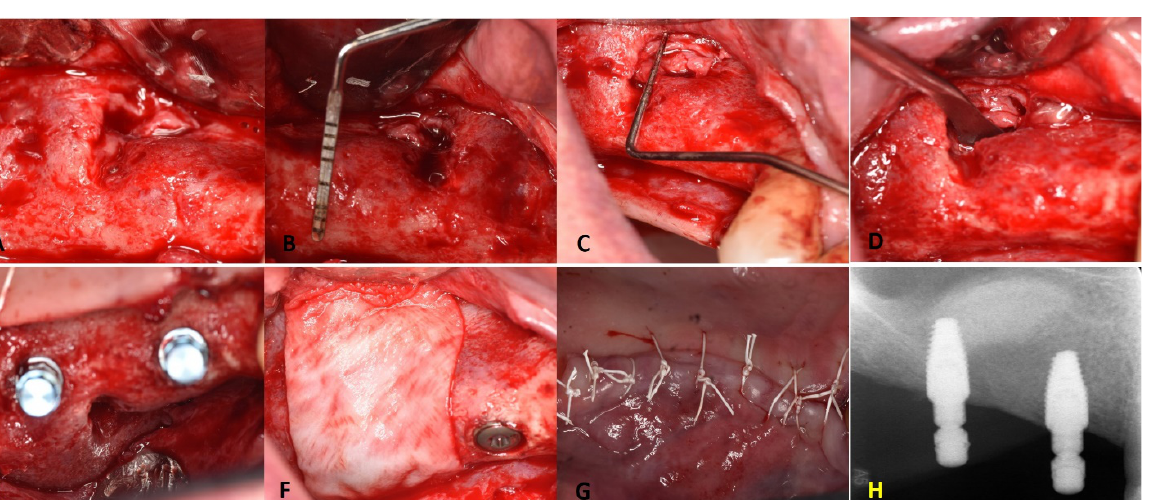
sinus window; ( B , C ) adequate width and height for implant placement. Partial healing of the sinus